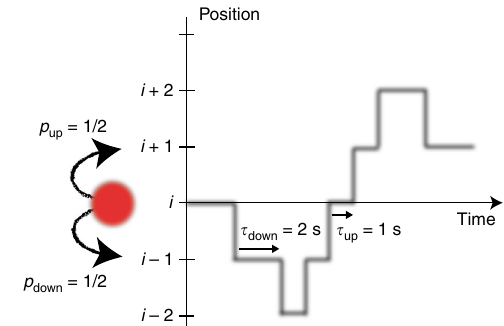
Fig. 1 Brownian particle jumping on an one-dimensional lattice. Jumps up and down are equally likely, but with asymmetric jump rates. As a result, the irreversibility of the dynamics is contained solely in the timing fl